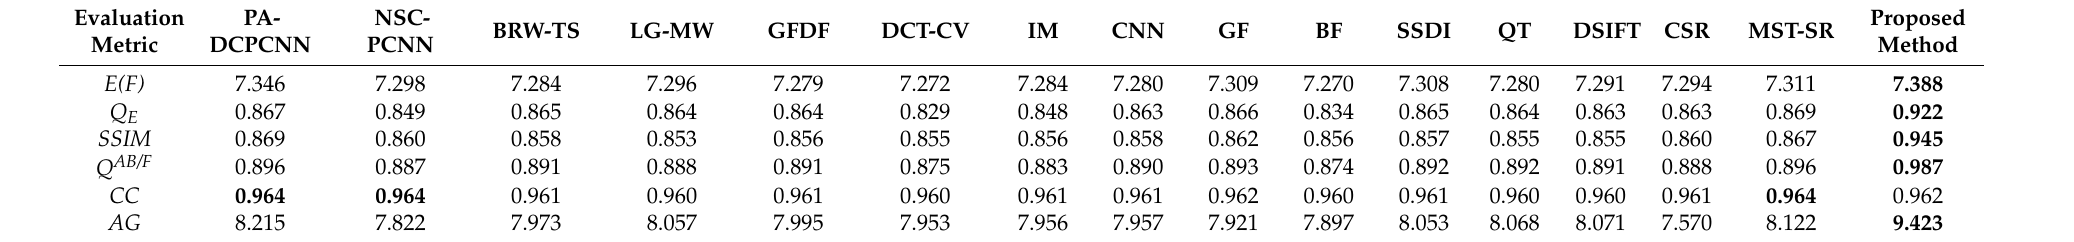
Figure 10. (Desk): ( a ) original image; ( b , c ) multi-focus input images; and ( d ) proposed fusion. Table 9. The outcomes for the desk image and comparisons with existing techniques in the literature ([21]).